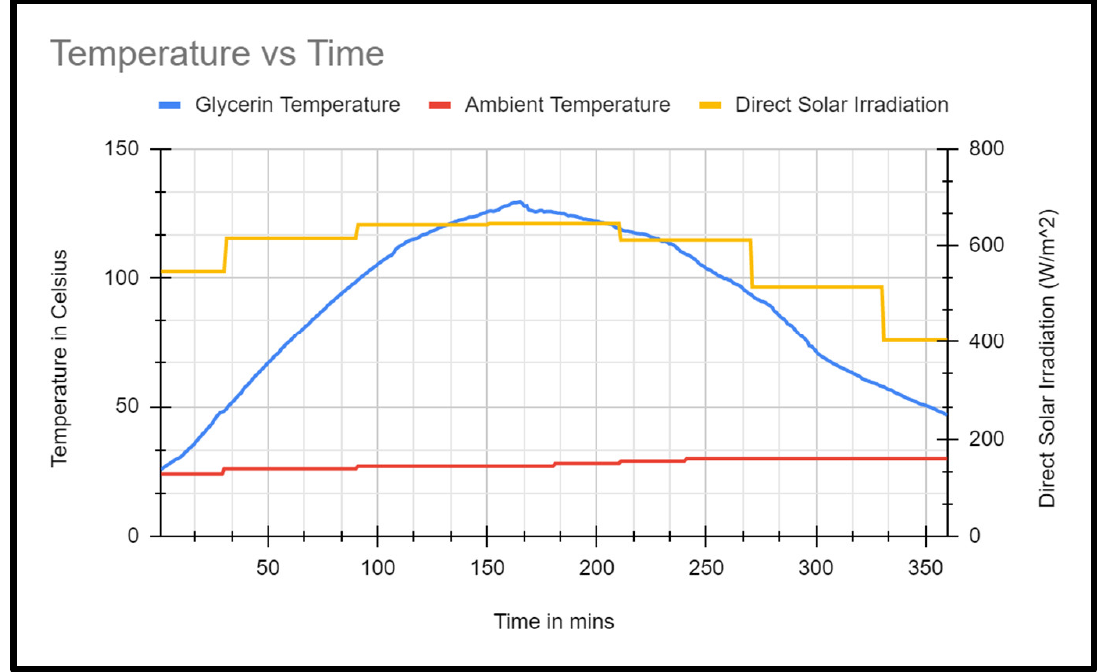
Figure 8. Temperature and irradiation values from day 2 using glycerine as test load.